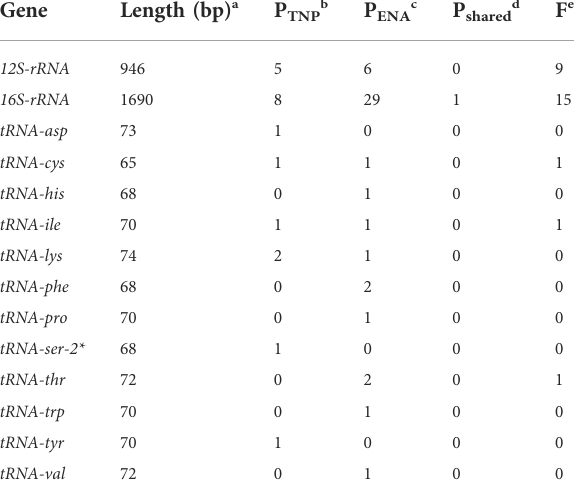
Asterisk after number 2 indicates it is the 3 ’ copy of tRNA-Ser . a length in base pairs based on the Trans-North-Paci fi c (TNP) reference genome; b polymorphisms exclusive to TNP mitotype; c polymorphisms exclusive to the Euro-North American (ENA) mitotype; d polymorphisms shared between TNP and ENA mitotypes; e fi xed differences between TNP and ENA mitotypes.